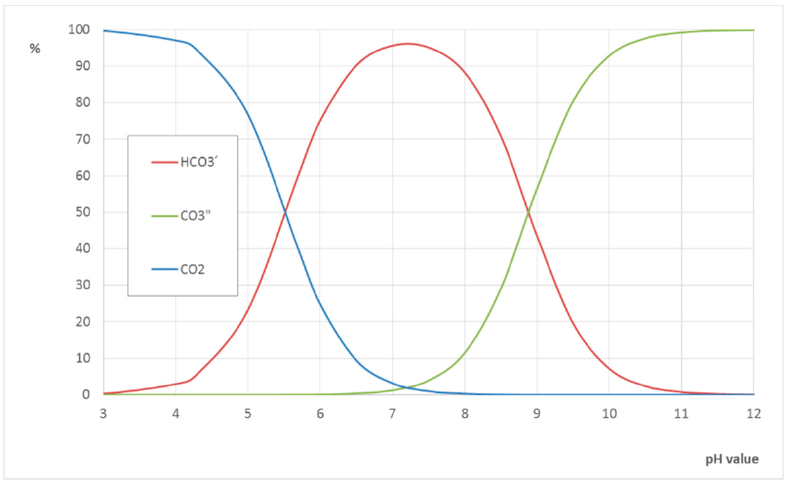
Figure 6. Dissociation equilibrium of CO 2 in pure water in dependence on the pH, T = 65 °C, p = 1.013 bar. p = 1.013